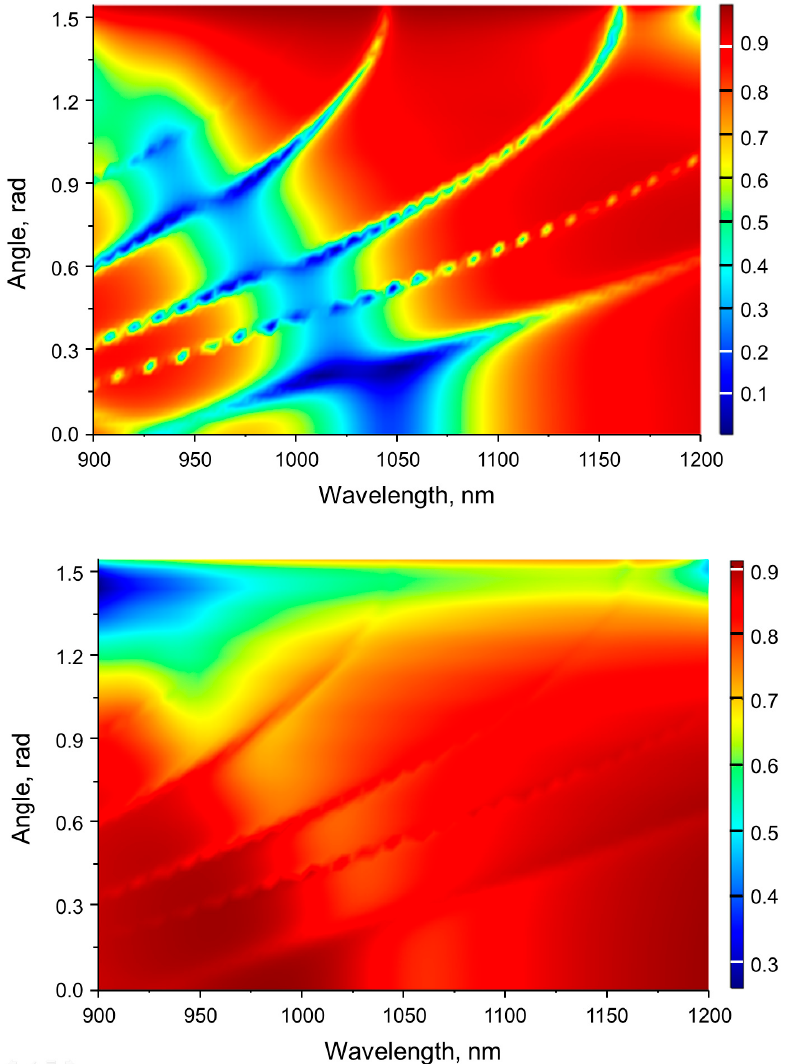
Figure 8. Full spectral dispersion of reflectance for TM polarization for the structure with embedded diffraction grating coupler (shown in Figure 1b,c) when illuminated from the top ( top image ) and from the bottom ( bottom image ).